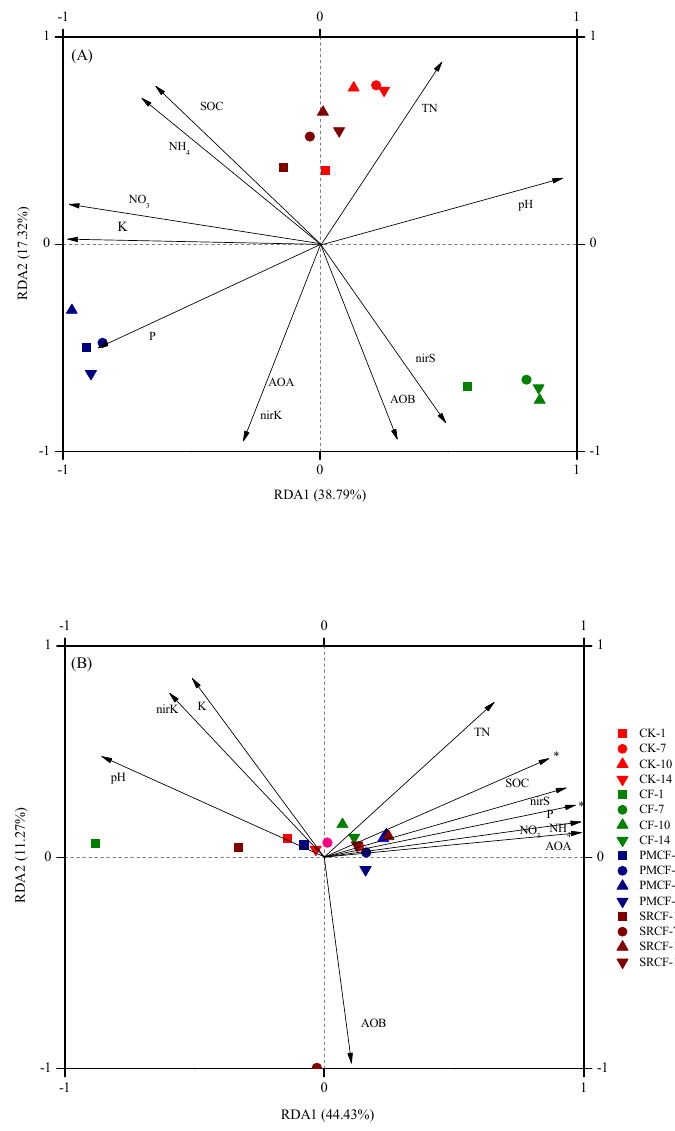
Figure 3. Redundancy analysis (RDA) performed between soil physicochemical characteristics and relative abundance of bacterial communities based on the Bray–Curtis distance at 1, 7, 10, and 14 days after incubation in soils collected from long-term experiment plots of the unamended control (CK), chemical fertilizers (CF), pig manure plus chemical fertilizer (PMCF), and rice straw plus chemical fertilizer (SRCF) under alternate wet–dry ( A ) or permanent flooding ( B ) conditions.